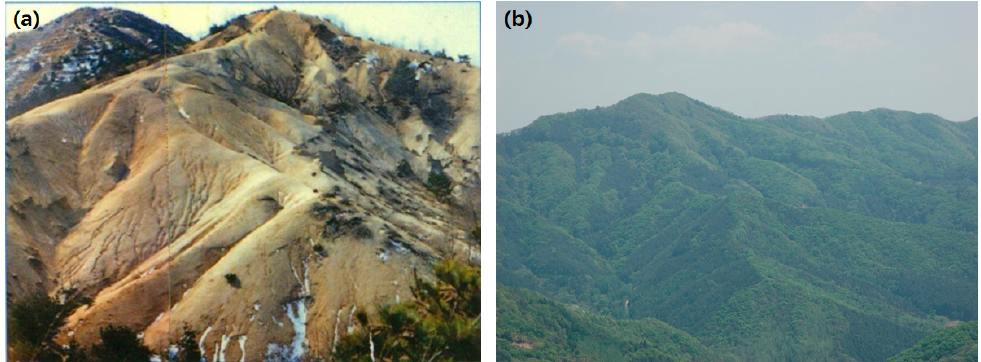
Figure 3. ( a ) Deforested lands in the mid-twentieth century (Photo from the Korea Forest Service)